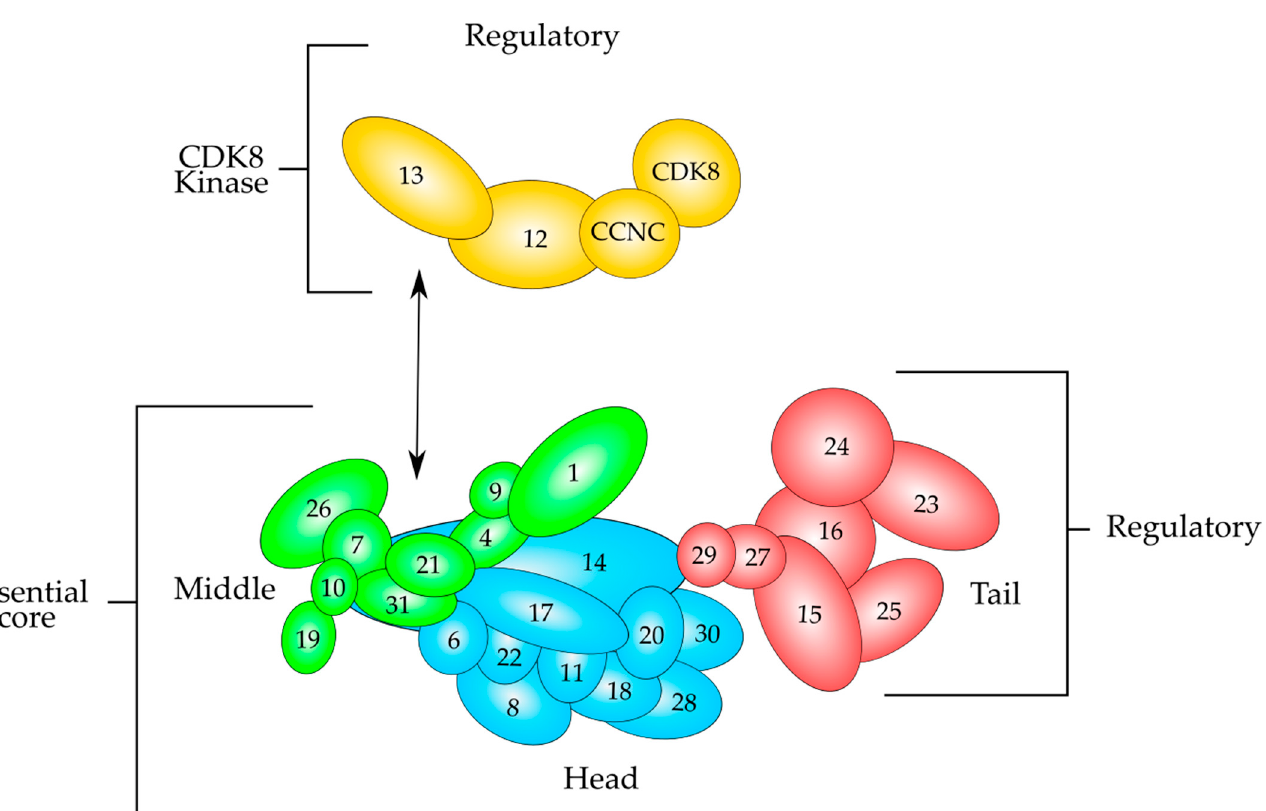
Figure 3. Schematic overview of the modular structure of the mammalian Mediator complex based on recent evidence derived from electron microscopy data. The Mediator consists of almost thirty polypeptides organized in three modules, which are Tail (red), Middle (green) and Head (cyan), which are held together by MED14. The Head and Middle modules constitute the essential core that is necessary for transcription regulation, whereas the Tail and the CDK8 kinase modules perform regulatory functions. The kinase module (yellow) consists of MED12, MED13 and the CCNC-CDK8 pair. This module associates to the Mediator after cell signaling and is able to repress transcription. CCNC-CDK8 pair can interact with MED12, and this polypeptide interacts with MED13, which tethers the Kinase module to the Mediator by interacting mainly with MED26 and MED1 of the Middle module. Modified from reference [41].